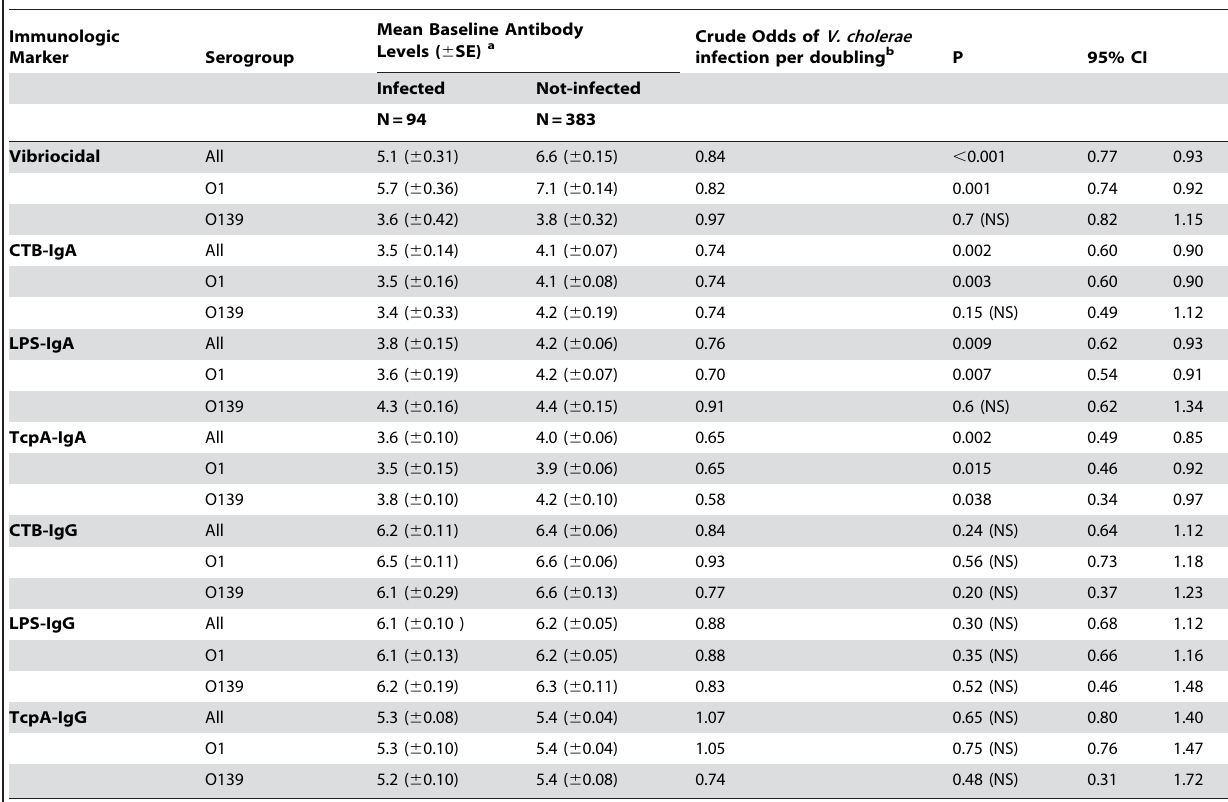
Table 2. Immunologic correlates of protection from infection with V. cholerae in household contacts